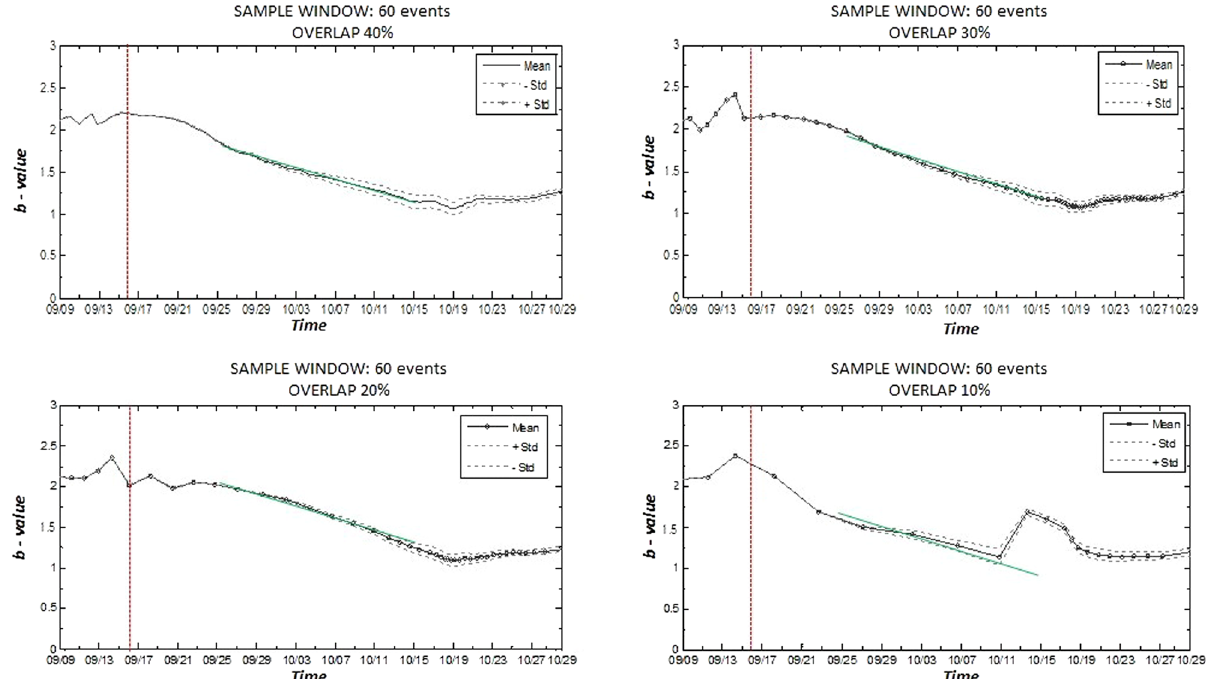
Figure 11. Analysis of the b-value as function of time with a window of 60 events and changing the overlapping between windows. The dotted-line represents the mean b-values and the dashed lines their variability (one standard deviation). The vertical red dash line represents the day when the injection stopped. The straight green line is the slope that characterizes the changes of the b-values. The figure was generated by using the ZMAP